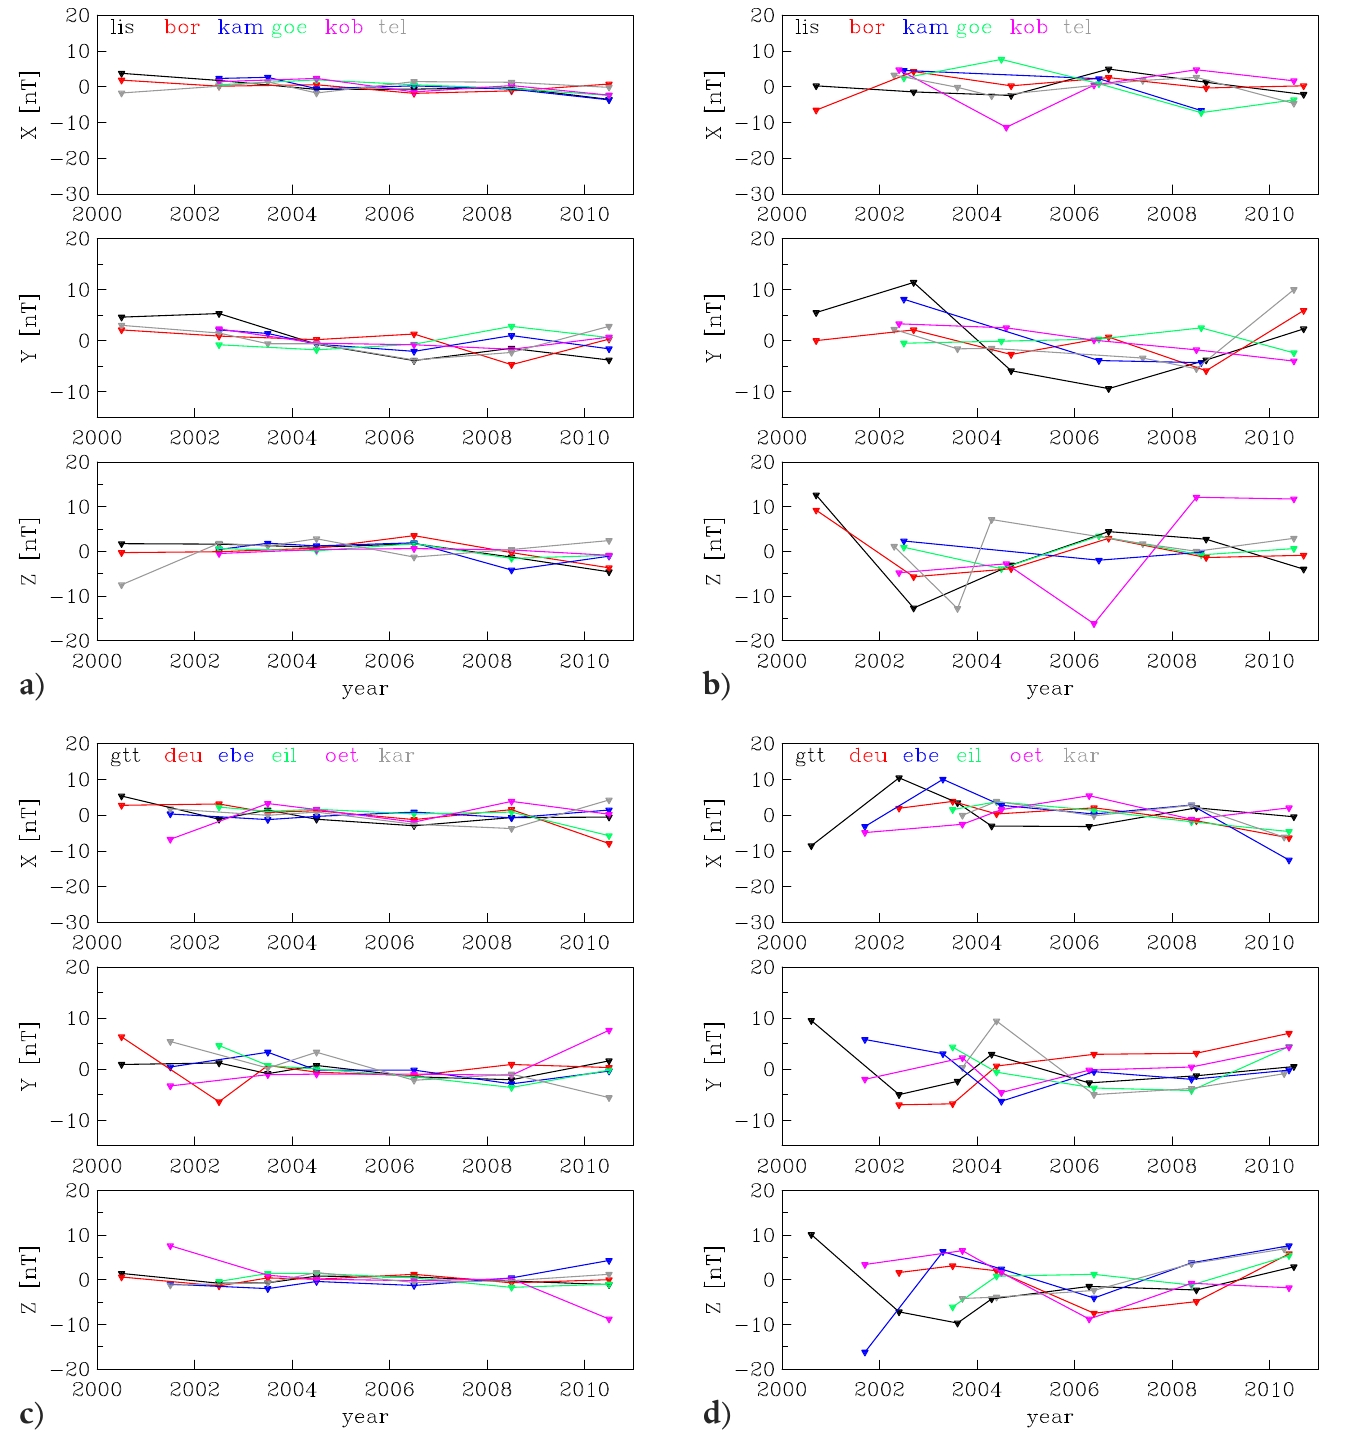
Figure 3. Repeat station data after subtraction of GRIMM3 core field predictions, a constant average for North (X), East (Y) and vertical (Z) component, and removal of external field influences. The left panels (a and c) show the annual means with the empirical external field correction. The right panels (b and d) show the quiet night time results where the GRIMM3 external field description has been used (see text for details). For better visibility the panels have been split up in northern (a and b) and southern (c and d)